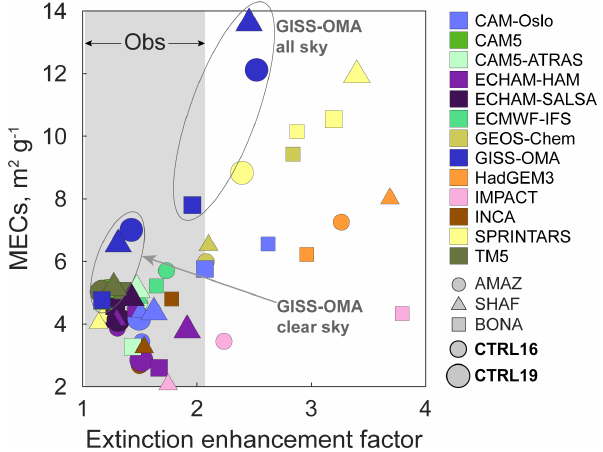
Figure 14. Dependence of modeled MECs on extinction enhance- ment factor (EEF) in models for 2010. The gray-shaded area shows the EEF range from in situ observations according to previous stud- ies (see Table 3). Both clear-sky and all-sky results are shown for GISS-OMA